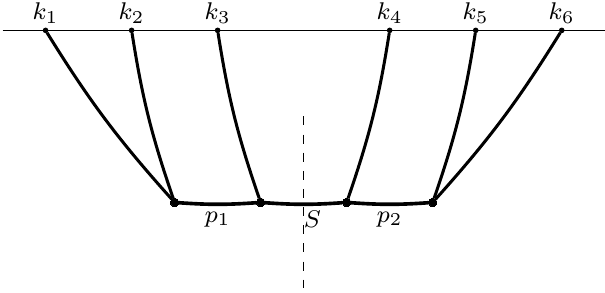
Figure 2 . Triple exchange 6 -point diagram for scalars cut into the product of two 4 -point exchange